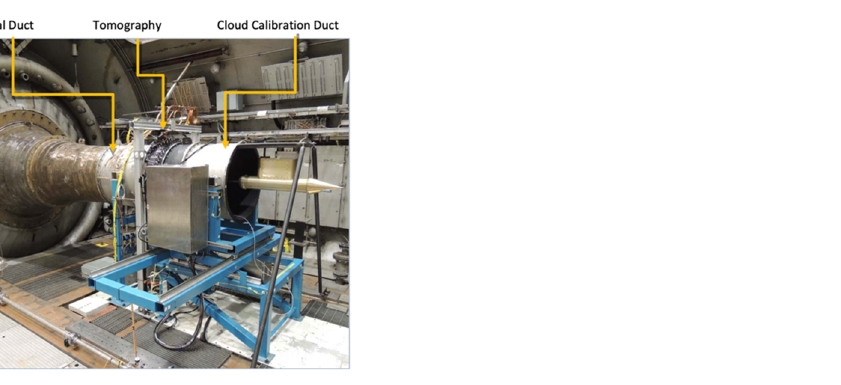
Figure 6. Cloud condition calibration test setup using the isokinetic probe (obtained from [85]).